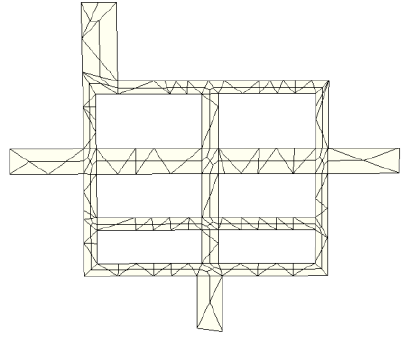
Figure 6 Axis extraction from delaunay